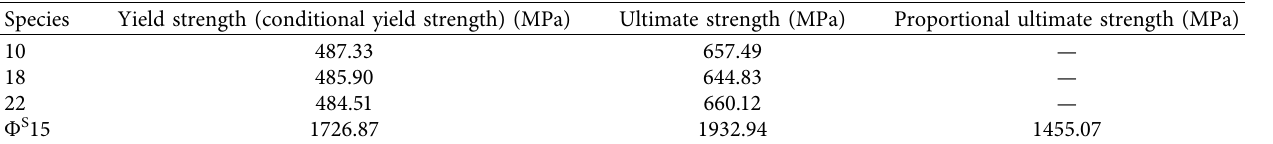
Table 3: Mechanical properties of steel